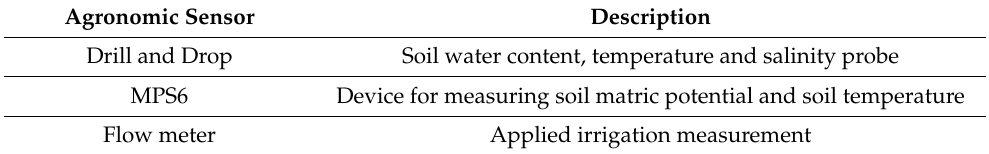
Table 1. List of agronomic sensors currently deployed in the plots monitored by the Irriman